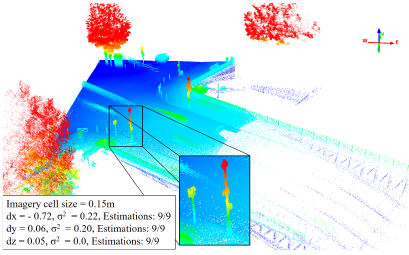
Figure 16. Relative transformation result of the example shown in Figure 1 with imagery of resolution 0.15m.